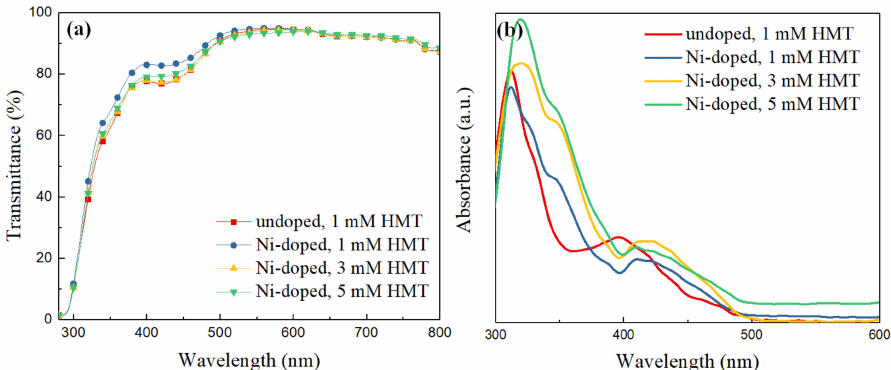
Figure 6. ( a ) Transmission and ( b ) absorption spectra of the undoped and Ni-doped ZnO NWLs with HMT concentrations of 1, 3, and 5 mM.